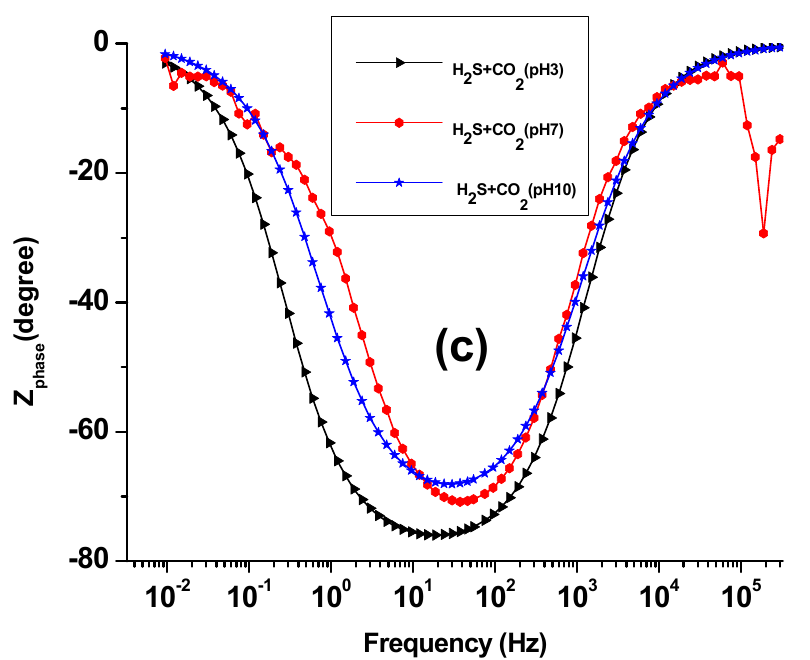
Figure 3. Phase magnitude plots in different solutions with different pH levels: ( a ) 3.5% NaCl + CO 2 , ( b ) 3.5% NaCl, and ( c ) CO 2 + H 2 S solution.